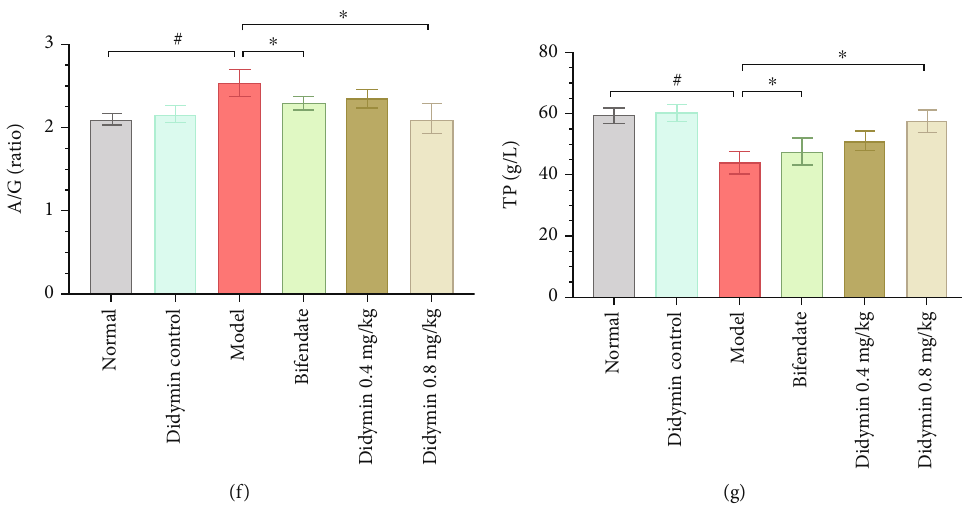
Figure 2: Didymin signi fi cantly alleviated LPS/D-Gal-induced ALI in mice. (a) The severity of LPS/D-Gal-induced ALI in mice was observed by H&E staining (400x); the arrow indicated necrosis. A1 to A6 represented the normal control, didymin control, model, bifendate, low, and high-dosage of didymin groups, respectively. (b – g) The levels of serum ALT, AST, ALB, GLB, A/G, and TP were detected using an automatic biochemistry analyzer. The data are presented as mean ± SD . # P < 0 : 05 vs. the normal group; ∗ P < 0 : 05 vs. the model